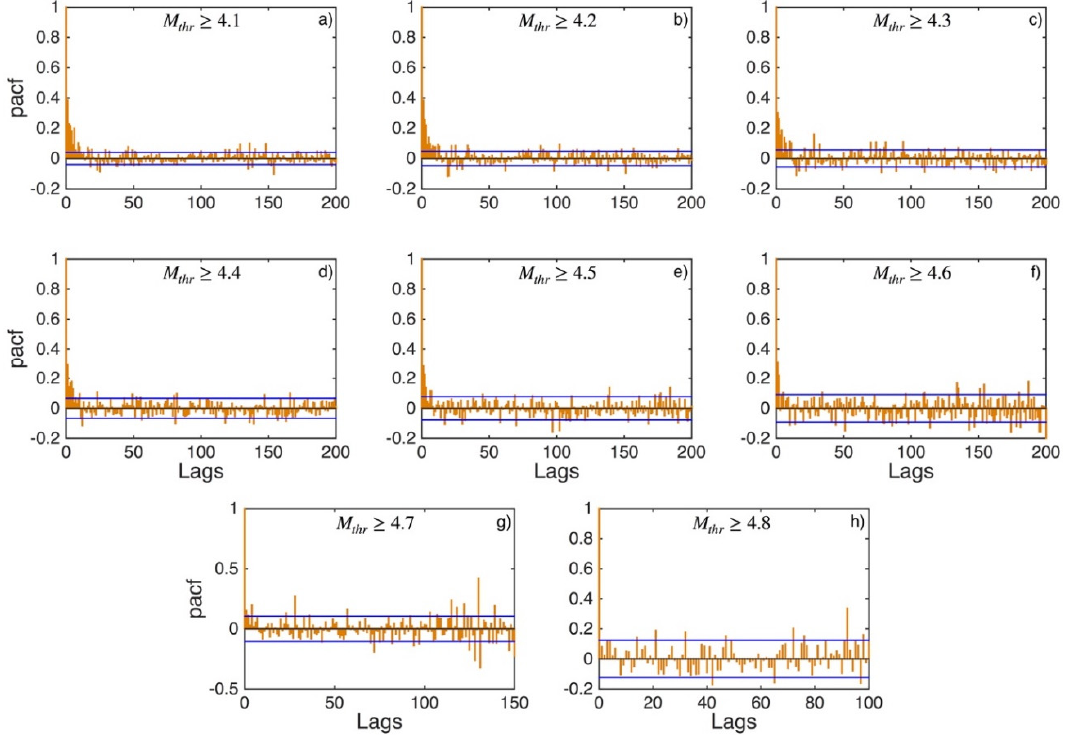
Figure A5. PACF values (orange stems) and their 95% confidence intervals (blue lines) for Western Hellenic Arc (sub − area 3) for magnitude thresholds ( M thr ) varying from 4.1 to 4.8 (subplots a – h ).